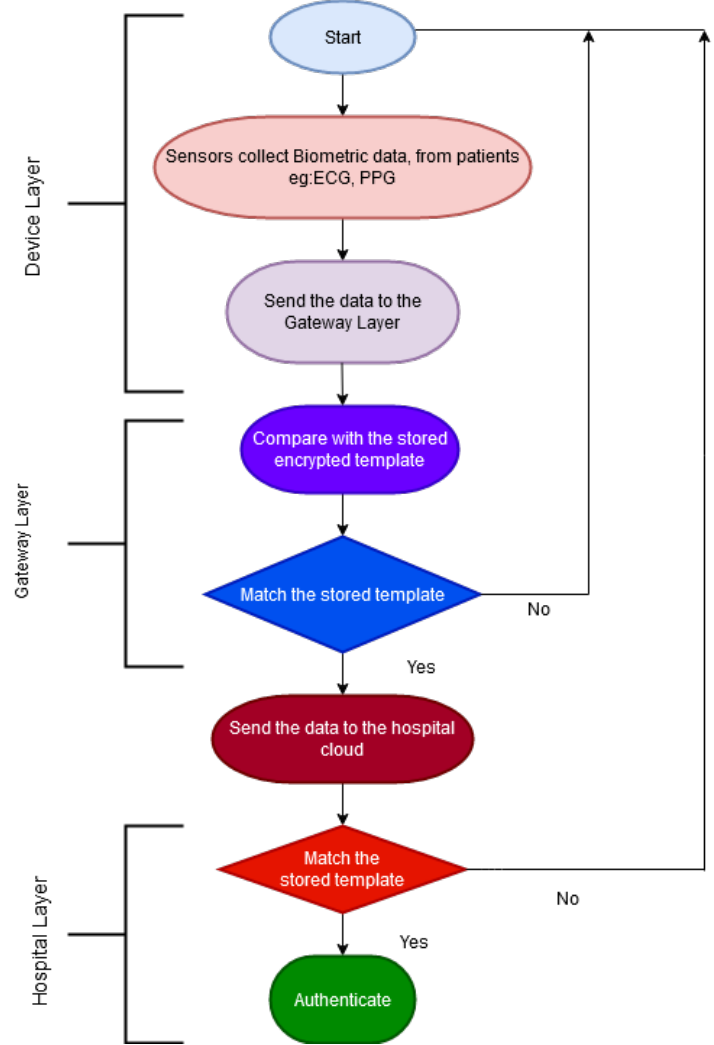
Figure 5. The authentication